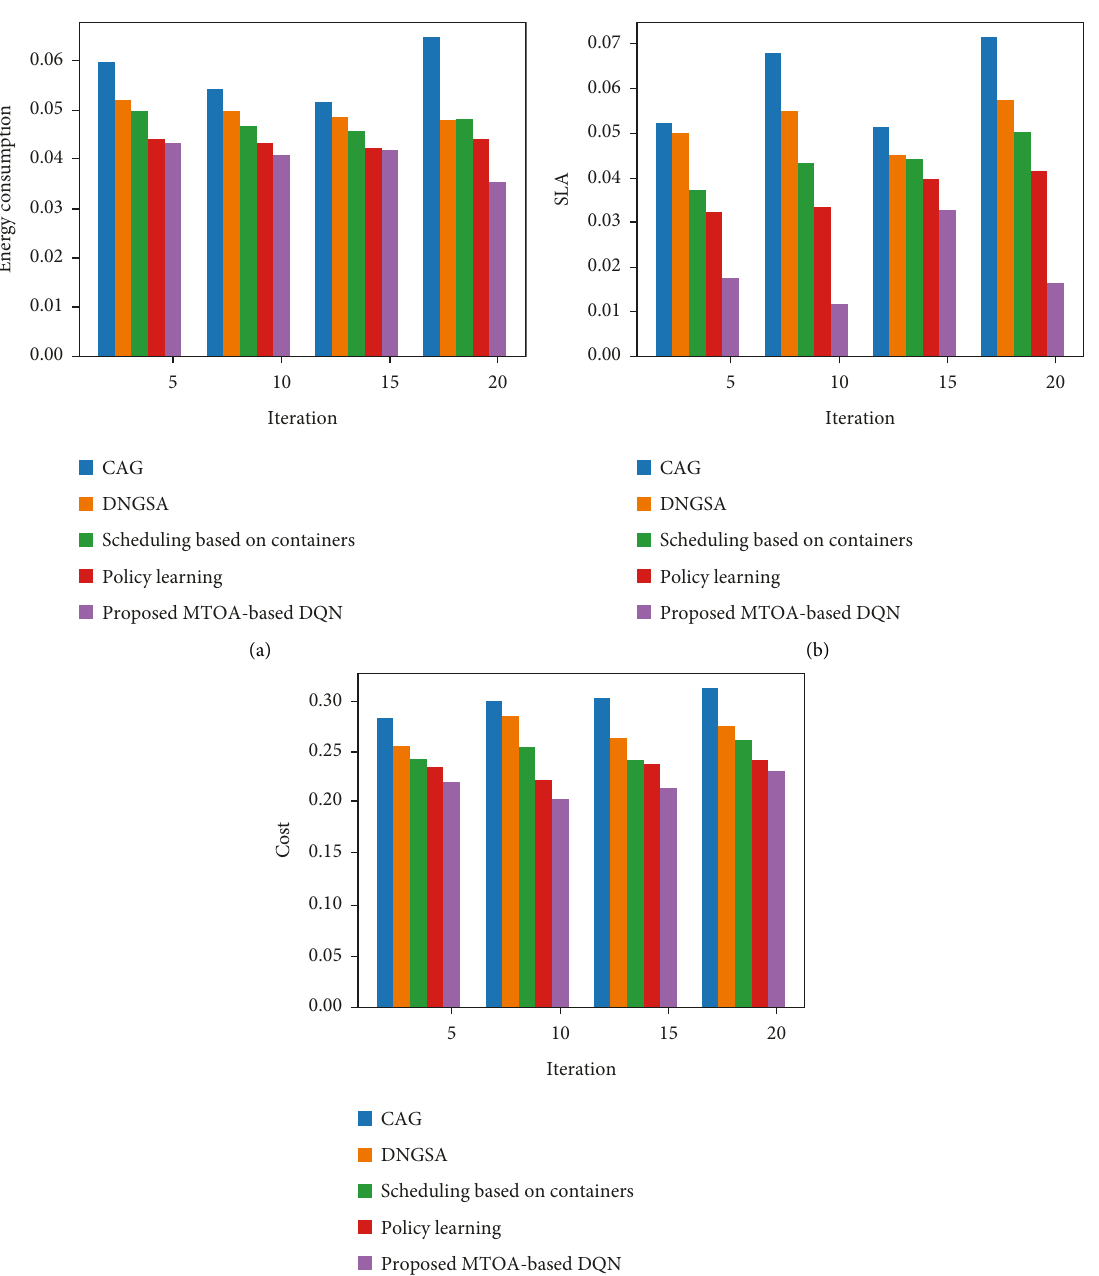
Figure 7: MTOA-based DQN with 250VM using Rnd data. (a) Energy consumption, (b) SLA, and (c)